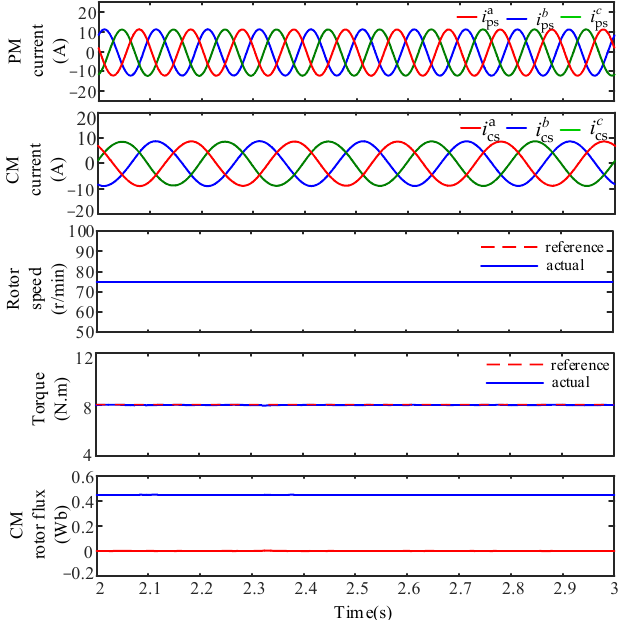
Figure 11. Simulation results of under-synchronization at 75 r/min. As shown in Figure 11, the load torque is 8 N.m. The rotor speed is stable at an under-synchronous speed of 75 r/min (the negative phase sequence of the CM power supply output and power supply frequency is 5 Hz). The CM rotor flux and the rotor speed are controlled to track the reference value